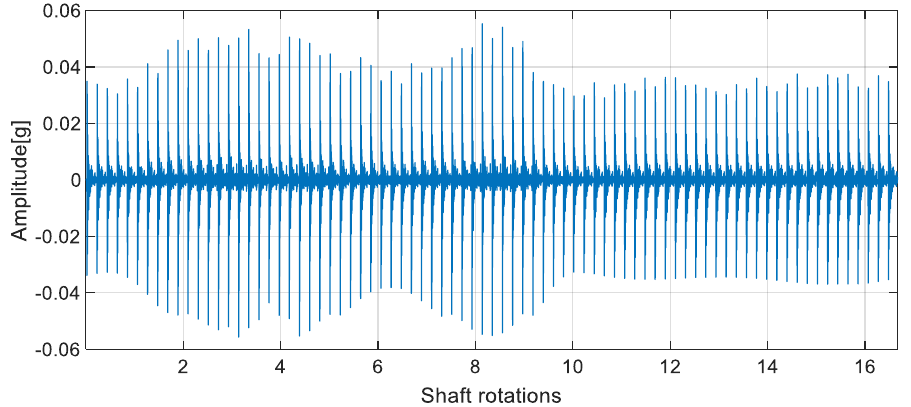
Figure 20. REB signal in angle domain with reference to shaft rotations.